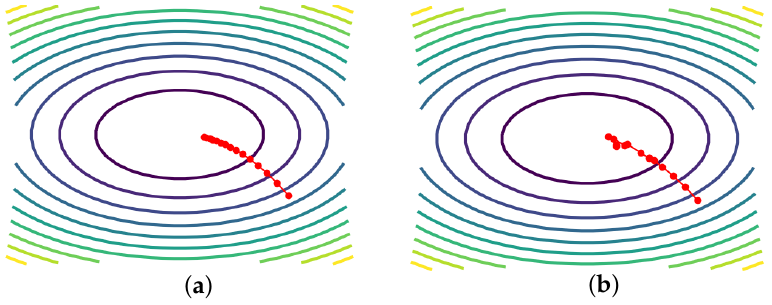
Figure 1. Comparison of SGD and GD. ( a ) GD, ( b )